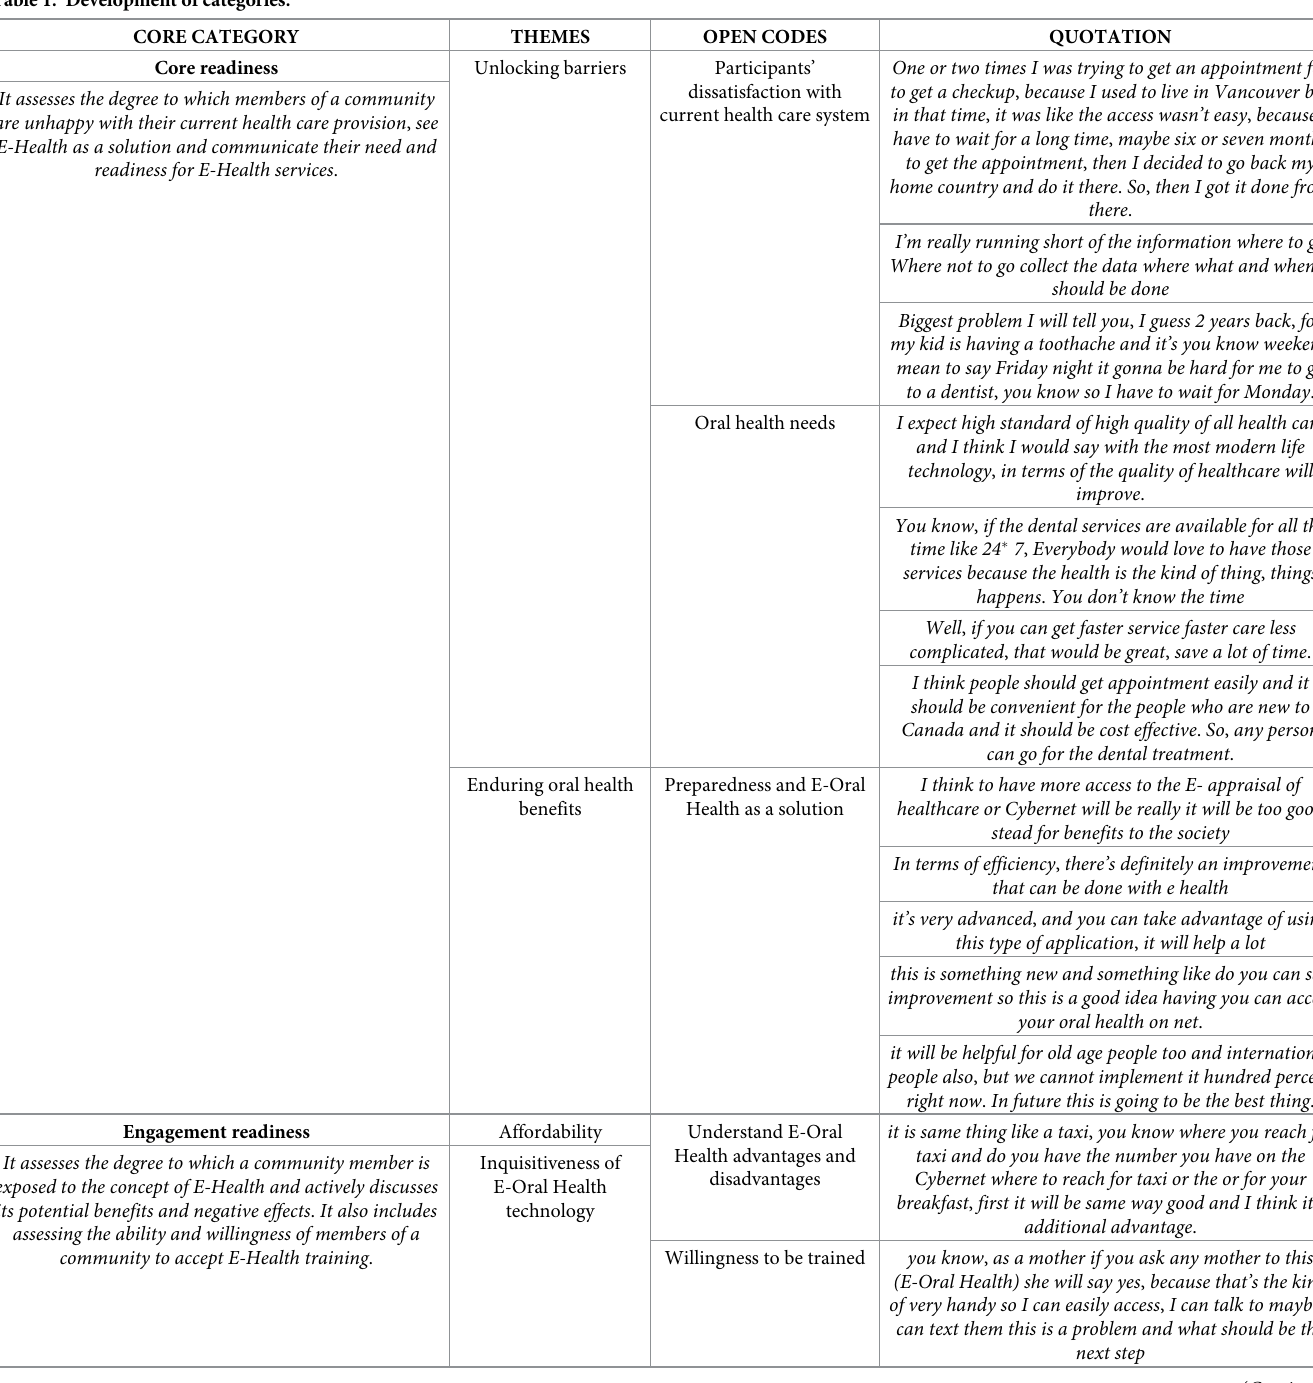
Table 1. Development of